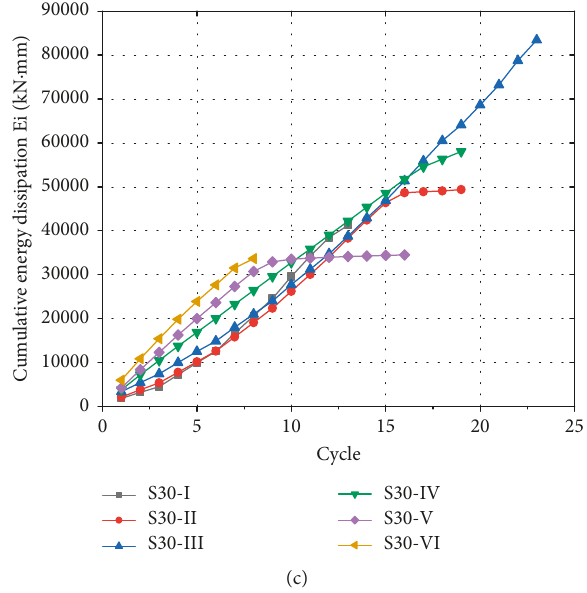
Figure 16: Comparison of cumulative dissipated energy. (a) S24 specimens. (b) S27 specimens. (c) S30